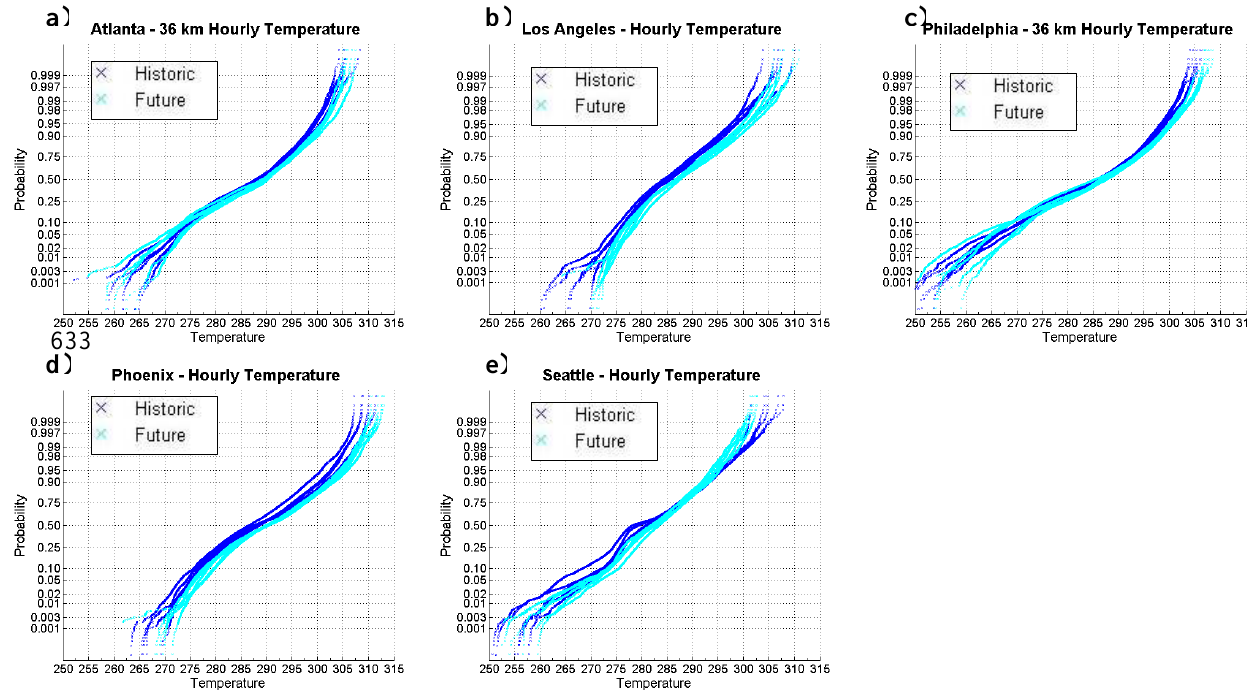
Figure 7: Empirically determined cumulative distribution of 36 km historic (2006-2010) and 635 Fig. 7. Empirically determined cumulative distribution of 36km historic (2006–2010) and future (2048–2050) hourly temperatures at major US cities: (a) Atlanta (b) Los Angeles (c) Philadelphia (d) Phoenix and (e) future (2048-2050) hourly temperatures at major U.S. cities: a) Atlanta b) Los Angeles c) 636